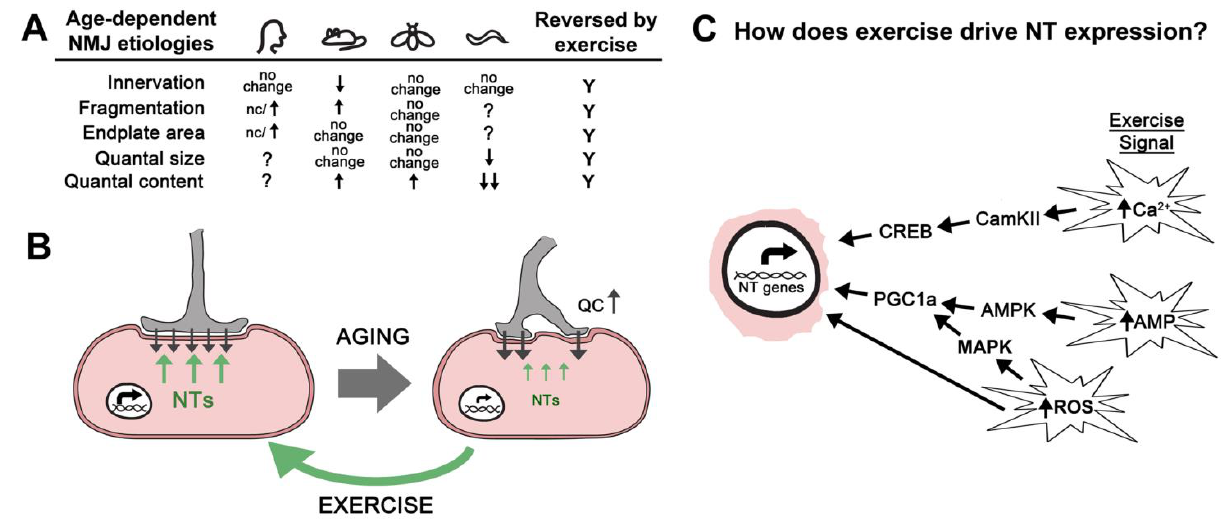
FIGURE 1: Exercise rejuvenates the neuromuscular junction by stimulating retrograde signaling. (A). Table contains the changes to the synaptic structure and function of the NMJ during aging from humans, mice, flies, and worms discussed in this review article. Inconsistent results about fragmentation at human NMJs are indicated. Exercise reverses all of these changes. (B) Aging results in reduced neurotrophin expression (NT; green arrows) leading to a loss of synaptic morphology and a compensatory increase in neurotransmitter release (quantal content = QC) at the neuromuscular junction (black arrows). Exercise increases the expression of multiple neurotrophin genes (NT genes; green arrows) resulting in improved structure and function of the neuromuscular junction. (C) Exercise results in increased cytosolic levels of calcium, reactive oxygen species (ROS), and an increase in the AMP:ATP and ADP:ATP ratios. We propose that these events initiate signaling cascades that result in the expression of neurotrophin (NT) genes via the activity of transcription factors such as CREB and PGC1a. It is ex- pected that mechanical stress and oxidative stress help to modulate these signal transduction pathways. It’s also possible that the oxidation of DNA directly alters expression of NT